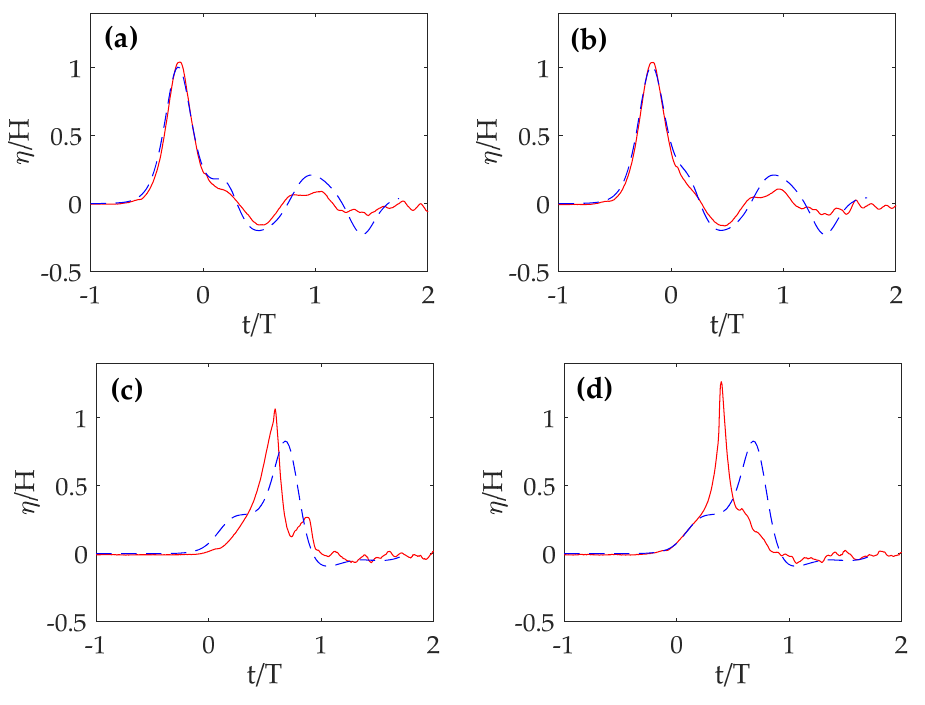
Figure 10. The time series of surface elevations in the front ( a ) WG1 and ( b ) WG2 and in the rear ( c ) WG3 and ( d ) WG4 of the plate over a flat bottom due to a solitary wave. (H/h = 0.326, d/h = 0.280).